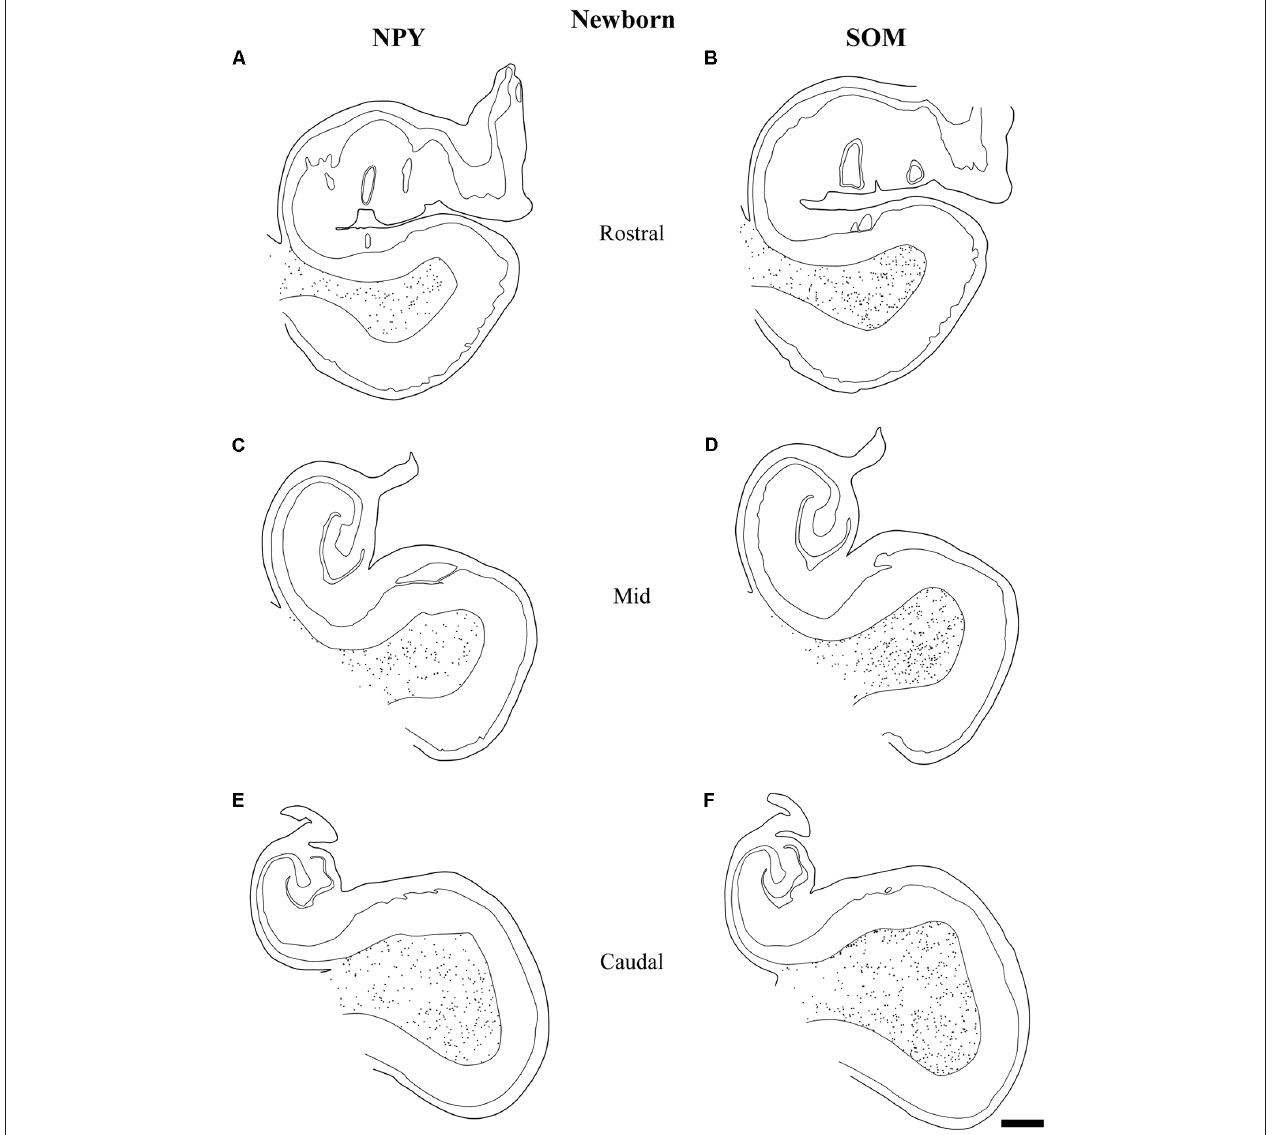
FIGURE 8 | The variation in density of both NPY and SOM-28 neurons at birth is depicted at three rostrocaudal levels of the angular bundle studied. Note the overall high, homogeneous density of labeled neurons for both neuropeptides in the angular bundle at the three levels. Other conventions as in Figure 3 . Scale bar is 2 mm.